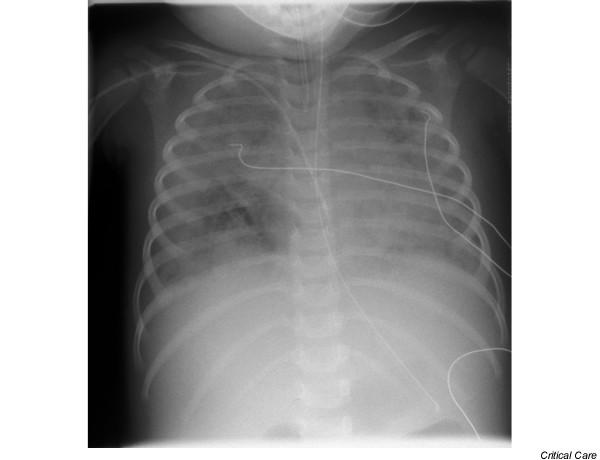
The girl: chest X-ray film, done after admission to hospital, showing increasing bilateral infiltrations of the lung, done after admission.